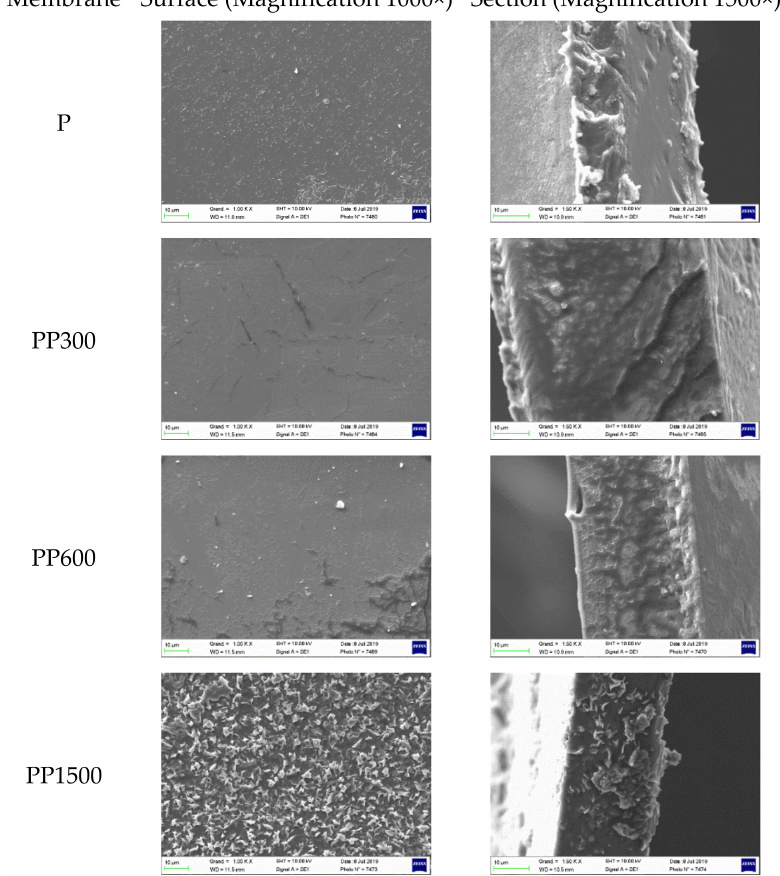
Figure 1. Surface and cross-section morphology of neat Pebax and Pebax/PEG (67/33 wt%) membranes.